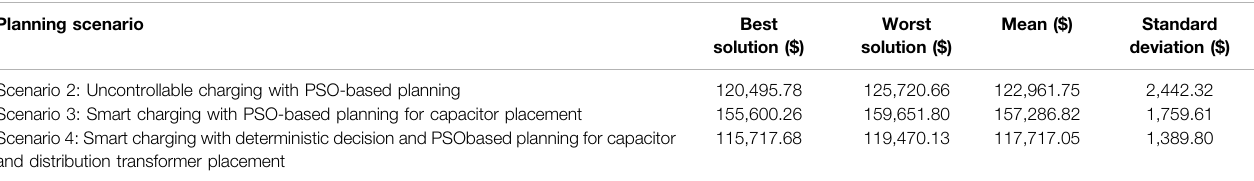
TABLE 5 | Best solution, worst solution, mean and standard deviation for each planning scenario. Planning